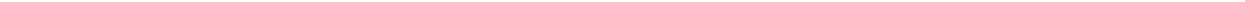
Fig. 4 Correlation and classi fi cation analyses between protrusion velocity and actin regulator dynamics. a – d Time-lag correlation analysis based on Pearson ’ s cross-correlation of edge velocity and actin ( a ), Arp3 ( b ), VASP ( c ), and HaloTag ( d ). Solid lines indicate population averages. Shaded error bands indicate 95% con fi dence intervals of the mean computed by bootstrap sampling. The number of samples used for the analysis is identical from Fig.3b – e. e Comparison and statistical testing of maximum correlation coef fi cients from a – d in each cluster. The error bar indicates 95% con fi dence interval of the mean by bootstrapping. ** p < 0.01, *** p < 0.001 and **** p < 0.0001 indicate the statistical signi fi cance by two-tailed two-sample Kolmogorov – Smirnov (KS) test. The p -values are listed in Supplementary Table 3. f – h Time-speci fi c correlation analysis based on pairwise Pearson ’ s correlation coef fi cients of protrusion velocity and fl uorescence intensity time series registered relative to protrusion onset. The regions surrounded by the black lines are statistically signi fi cant correlation by Benjamini-Hochberg multiple hypothesis testing. i Pearson ’ s correlation coef fi cients between early Arp3 intensities and late protrusion velocities in each cluster. The error bar indicates 95% con fi dence interval of the mean by bootstrapping. The numbers of samples in this analysis are 204 (Cluster I), 112 (Cluster II-1), 161 (Cluster II-2), 178 (Cluster II-3) and 102 (Cluster III) respectively. j – k Classi fi cation analysis of Cluster III against Clusters I/II based on fl uorescent intensity time series. Boxplots of the accuracy ( j ) and Matthews correlation coef fi cients ( k ) represent multiple classi fi cation results. RF stands for Random Forest, DNN for Deep Neural Network, and SVM for Support Vector Machine. The central line indicates median, and both edges of the box each represent 25 th and 75 th percentiles. The numbers of samples used in these analyses are 934 (actin), 757 (Arp3) and 682 (VASP)